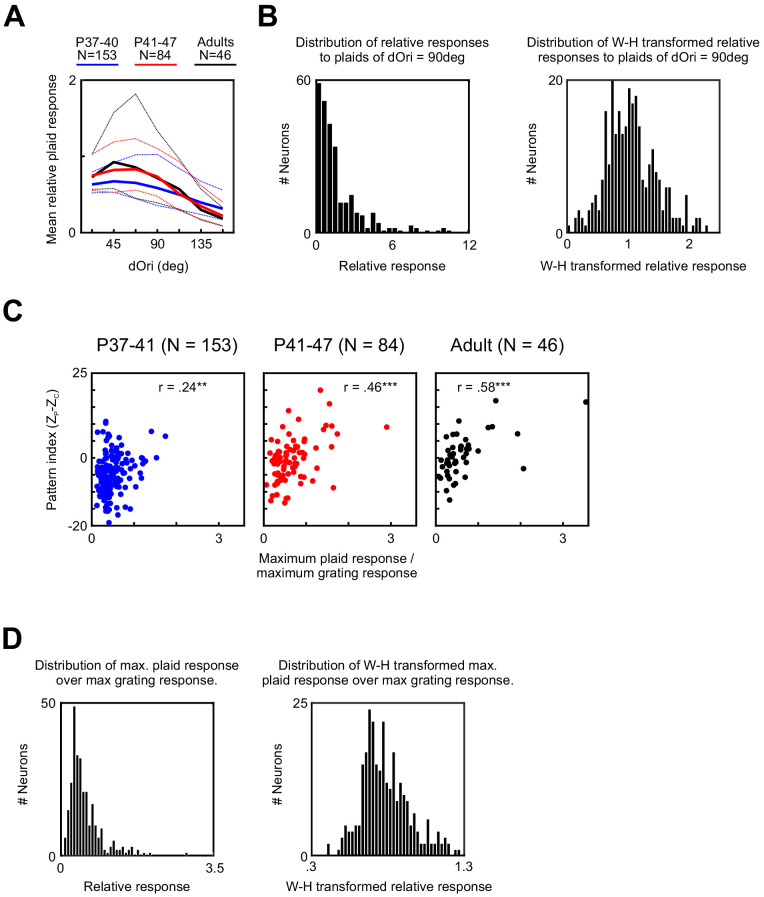
Relative plaid responses in PSS and the Wilson–Hilferty transformation.(A) Average relative plaid response in PSS as a function of dOri. For each age group, curves indicate the median (solid line) and upper and lower 25th percentile (dotted lines). (B) Distribution of the relative plaid response, computed as the ratio between the mean response to plaids of dOri = 90 deg and the mean response to gratings. Distribution is shown for all PSS cells before (left) and after (right) applying the Wilson–Hilferty transformation. (C) Ratio between the maximum response to plaids (dOri = 90 deg) and the maximum response to gratings versus pattern index at different ages. Same data as in Figure 4C, but without the Wilson–Hilferty transformation. (D) Distribution of the ratio between the maximum response to plaids (dOri = 90 deg) and the maximum response to grating for all PSS cells before (left) and after (right) applying the Wilson–Hilferty transformation.